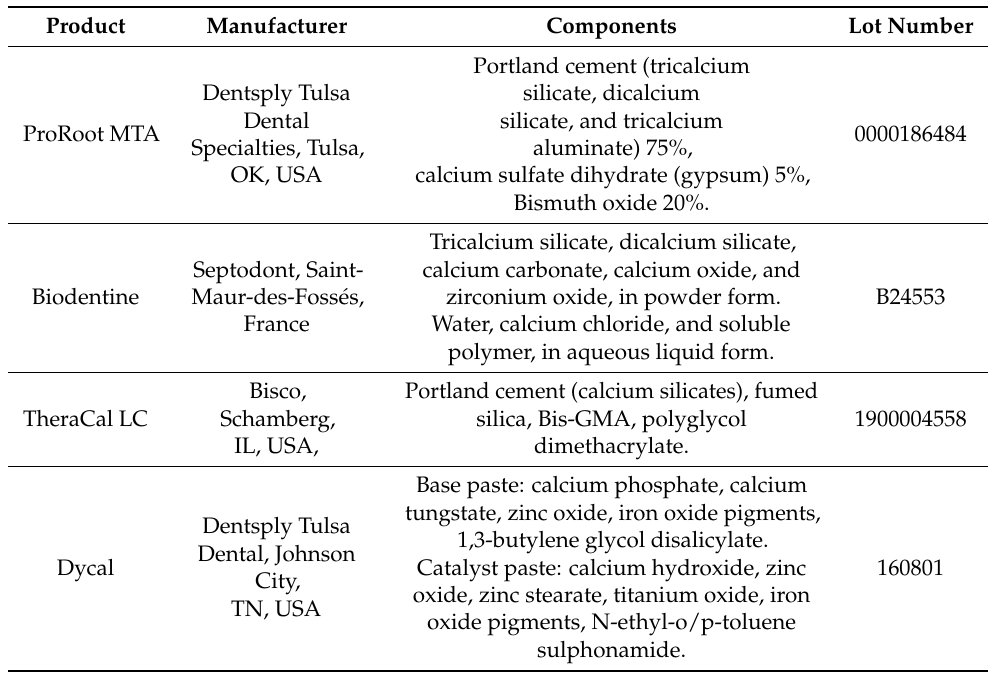
Table 1. Manufacturers and chemical components of the experimental materials for direct pulp